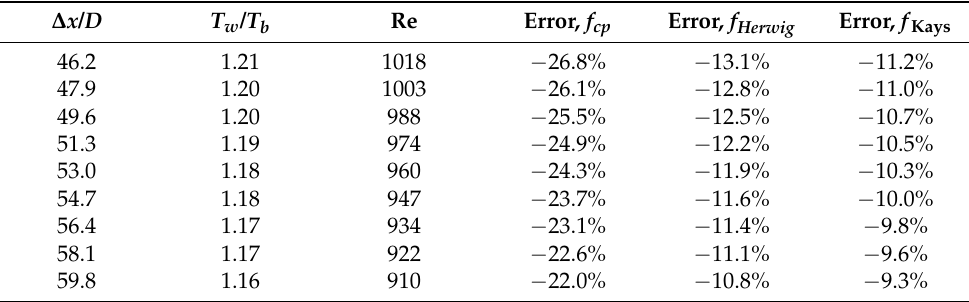
Table 6. Calculation errors of HeXe14.5 by laminar f correlations with case